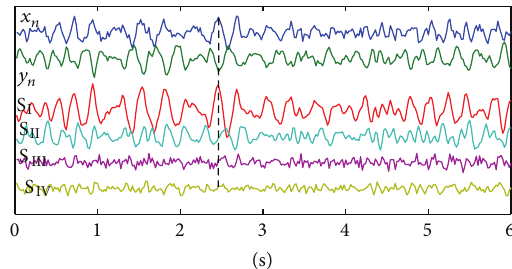
Figure 2: Example of the decomposition of the posturographic signal using spatiotemporal decomposition. The input PCA matrix was built from 4 columns: I: 𝑥 𝑛 (1 ∼ 1023), II: 𝑥 𝑛 (2 ∼ 1024), III: 𝑦 𝑛 (1 ∼ 1023), and IV: 𝑦 𝑛 (2 ∼ 1024). Columns I-II and III-IV reflect the same signals being shifted in time by one sample (i.e., 𝑡 = 0.02 s). The two upper signals represent the 𝑥 𝑛 and 𝑦 𝑛 signals after high-pass filtering 𝑓 = 3 Hz. The 4 lower signals are the PCA columns after and 𝑆 represent mainly the signal. 𝑆 and 𝑆 rotation. The 𝑆 I II III IV represent mainly the noise. The synchronous deflection in 𝑥 𝑛 and 𝑦 𝑛 is connected with high amplitude of the deflection in 𝑆 (see dashed I